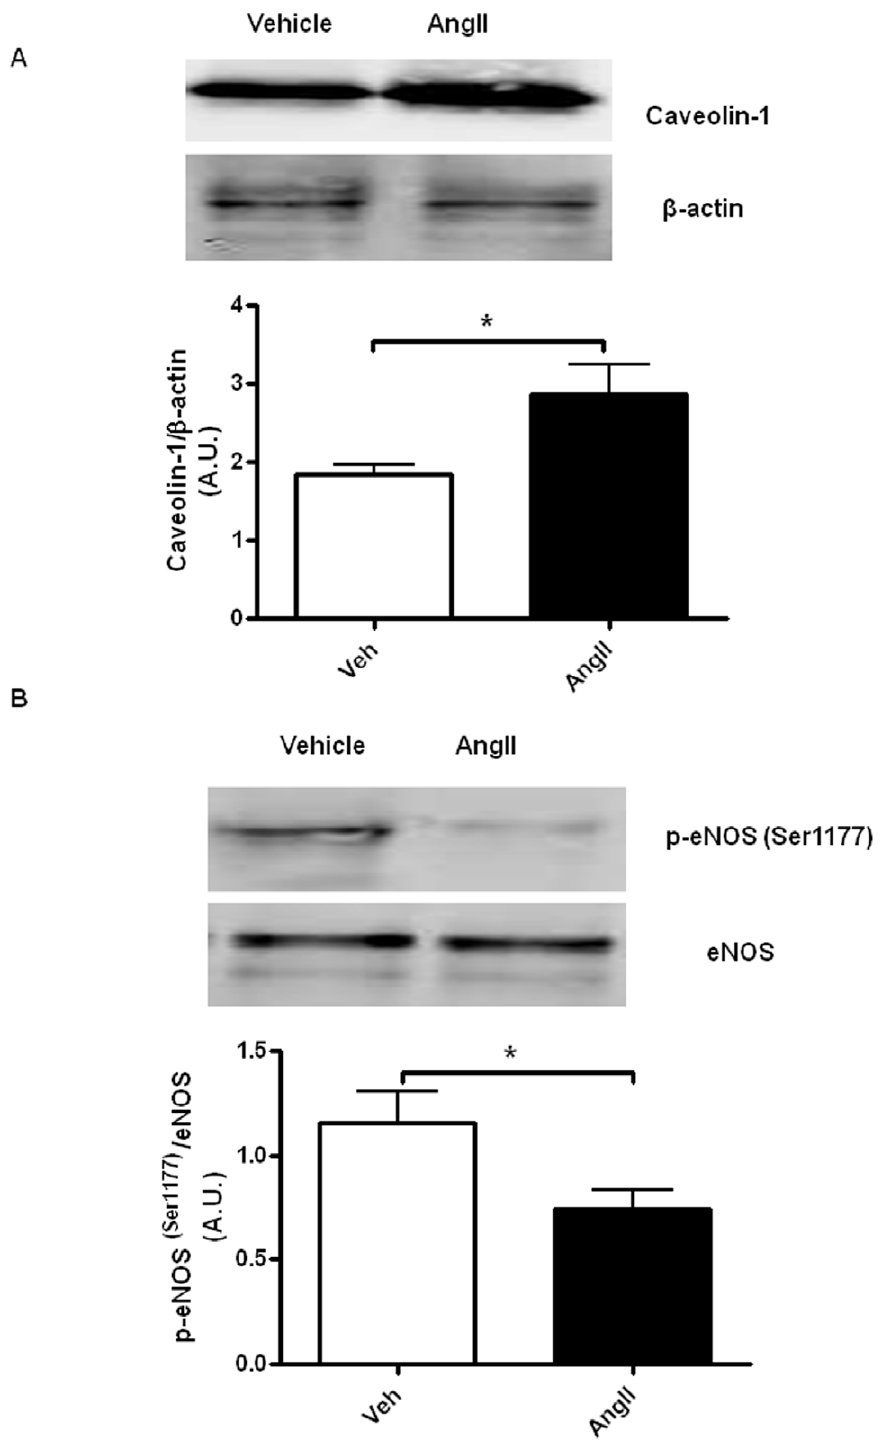
Figure 3. AngII infusion alters aortic Cav-1 and phospho-eNOS expressions. (A) Representative Western blot analysis of caveolin-1 protein expression in aortas of saline-infused (Veh) and AngII-infused (AngII) ApoE 2 / 2 mice. Bar chart indicates results of relative densitometry analysis of caveolin-1 protein relative to b -actin. (B) Representative Western blot analysis of phospho-eNOS (Ser1177) and total eNOS protein expression in aortas of saline-infused (Veh) and AngII -infused (AngII) ApoE 2 / 2 mice. Bar chart indicates results of relative densitometry analysis of p-eNOS protein relative to total eNOS. Results are mean 6 SEM; n=6; Statistical significance shown as *P , 0.05. doi:10.1371/journal.pone.0058481.g003 significantly greater at 3 m M (Control: 44.72 6 11.62; M b CD: concentration-response curve when compare with the non-M b CD 75.07 6 4.07) (P , 0.05; n= 5) with a leftward shift of the treated aortas. However, M b CD did not alter acetylcholine-